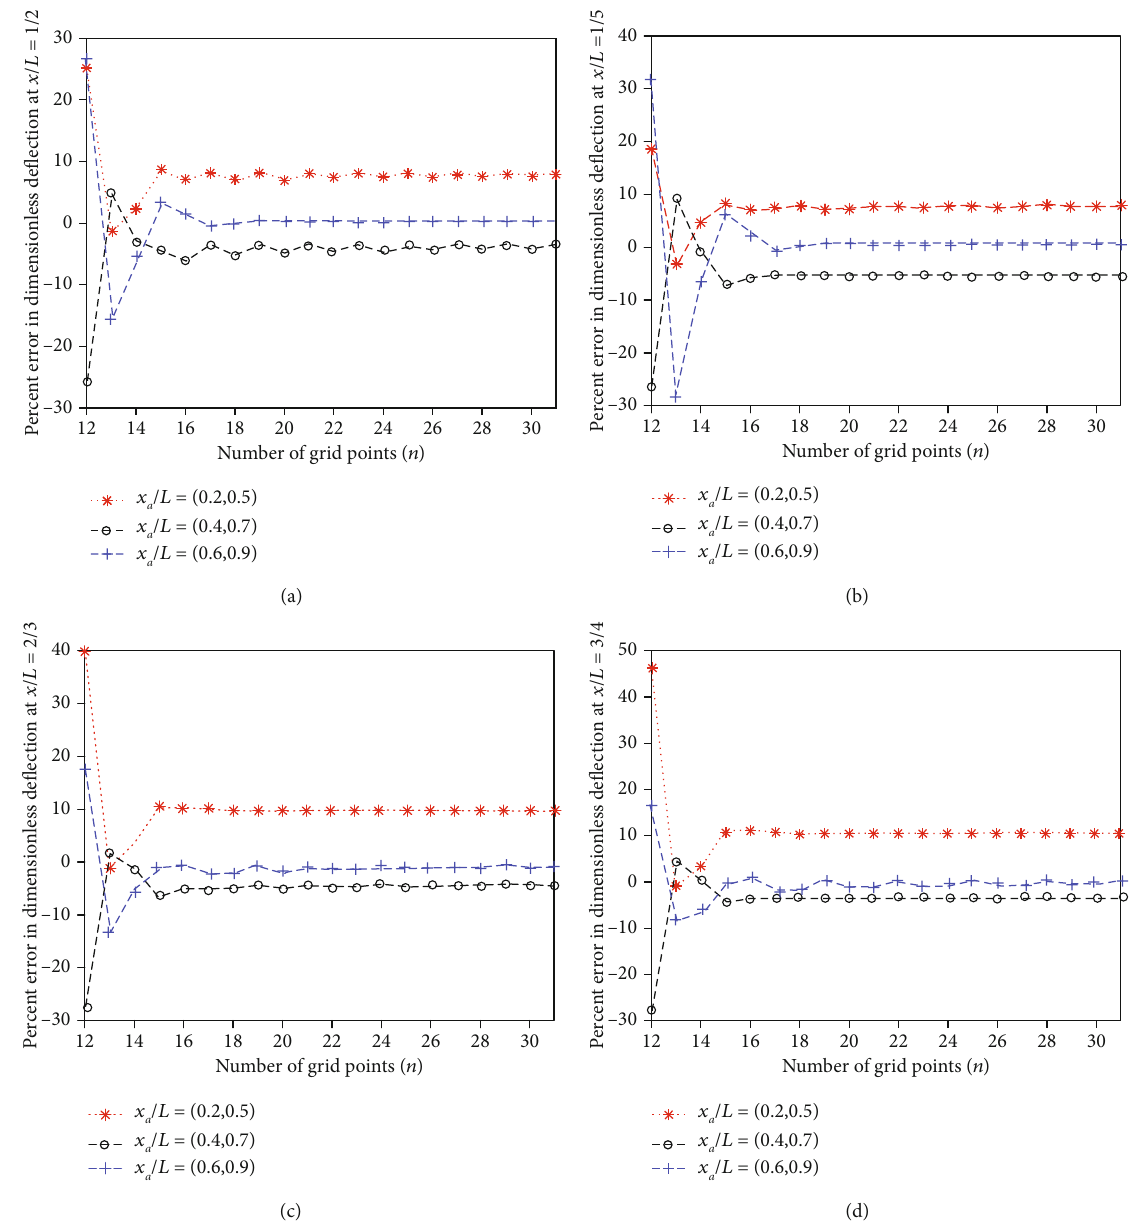
Figure 2: Convergence and accuracy of the dimensionless de fl ection of a simply supported beam under a constant voltage V actuator at various locations for ( α = 0 : 25 ) at x / L = 1/2 (a), x / L = 1/5 (b), x / L = 2/3 (c), and x / L = 3/4